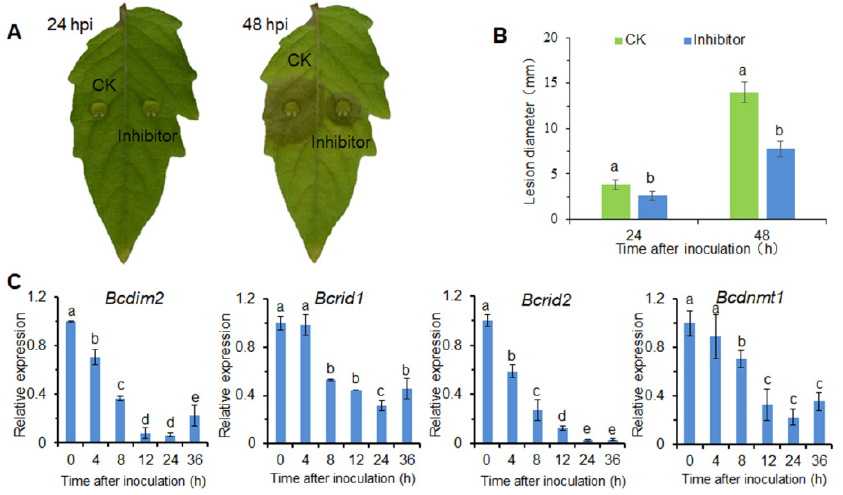
Figure 1. DNA methylation is involved in the infection process of B. cinerea . ( A ) Disease symptoms of detached tomato leaves after inoculation with 5-Aza-treated (1 mm) and non-treated conidia. ( B ) Statistical analysis of lesion diameter caused by 5-Aza-treated (1 mm) and non-treated conidia on detached tomato leaves. ( C ) Relative expression of DNA methyltransferase genes during infection processes of B. cinerea . Vertical bars represent standard errors of the means. Columns with different letters indicate significant differences ( p < 0.05).